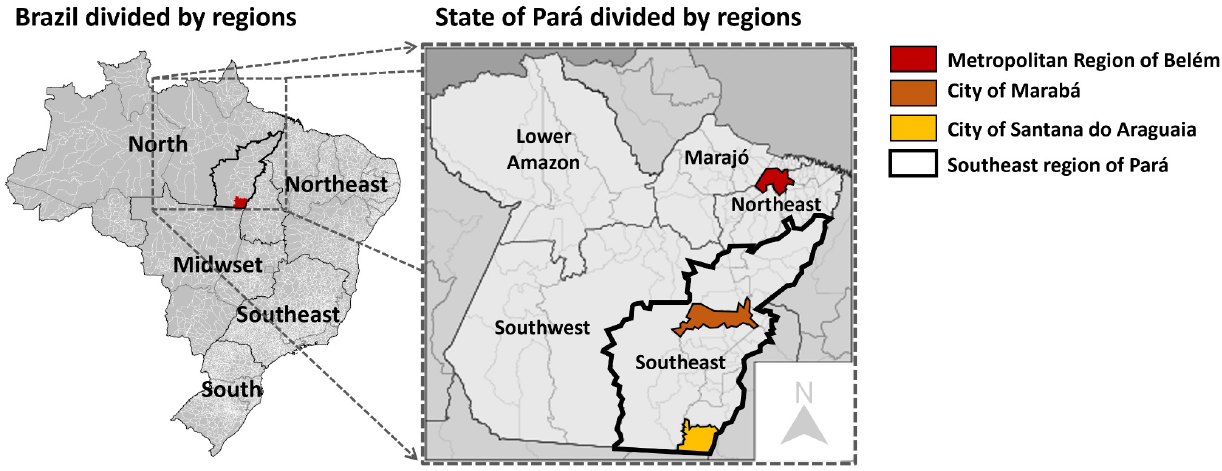
Figure 1. Location of Santana do Araguaia in Brazil and the state of Pará. Social Inclusion, 2022, Volume 10, Issue 2, Pages